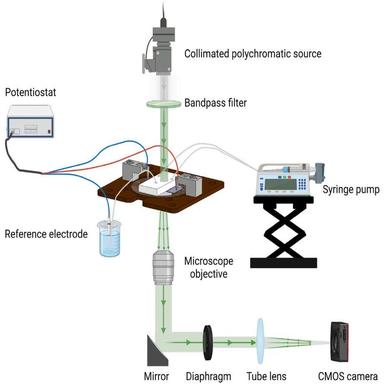
Schematic of visible spectroscopic imaging setup used to measure in operando concentration.